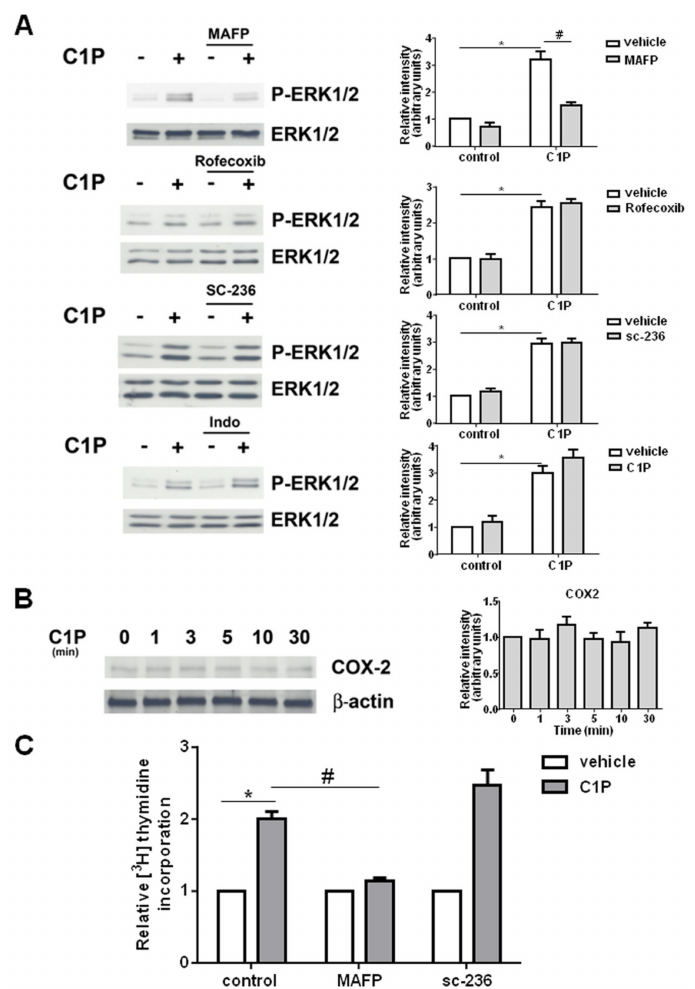
Figure 3. The mitogenic effect of C1P requires PLA2 but not COX2 activation. ( A ) Serum-starved C2C12 cells were pre-incubated for 30 min in the presence or absence of 25 µ M MAFP or 100 µ M Rofecoxib or 10 µ M SC-236 or 50 µ M Indomethacin (Idon), before being stimulated with 15 µ M C1P for 5 min. ERK1/2 activation was measured in total cell lysates by Western blotting analysis using anti-phospho-ERK1/2 antibody. A blot representative of three independent experiments is shown. Right panels: Band intensity was quantified by densitometric analysis and normalized to the expression of total ERK1/2. C1P activates ERK1/2 in a statistically significant manner by by Student’s t test (* p < 0.05); the effect of PLA2 inhibition by MAFP, and not by Rofecoxib or SC-236 or Indomethacin, was statistically significant by two-way ANOVA followed by Bonferroni’s post hoc test ( # p < 0.05). ( B ) Western blot analysis was performed using specific anti-COX2 antibody in cell lysates prepared from serum-starved myoblasts treated with 15 µ M C1P for the indicated time intervals. A blot representative of at least three independent experiments with analogous results is shown. Right panel: Band intensity was quantified by densitometric analysis and normalized to the expression of β -actin. ( C ) Serum-starved C2C12 myoblasts were pre-incubated for 30 min in the presence or absence of 25 µ M MAFP or 10 µ M SC-236 before being stimulated with 15 µ M C1P for 16 h. [ 3 H]Thymidine (0.5 µ Ci/well) was added during the last hour of incubation. Data are mean ± SEM of at least three independent experiments performed in triplicate. [ 3 H]Thymidine incorporation in untreated control cells was 12,322.33 ± 2691.68 dpm, in MAFP-treated cells was 10,112.33 ± 916.04 dpm, and in SC-236-treated cells was 2905.3 ± 379.44 dpm. The mitogenic effect of C1P was statistically significant by Student’s t test (* p < 0.05); the effect of PLA2 inhibition by MAFP, but not by sc-236, was statistically significant by two-way ANOVA followed by Bonferroni’s post hoc test ( # p <